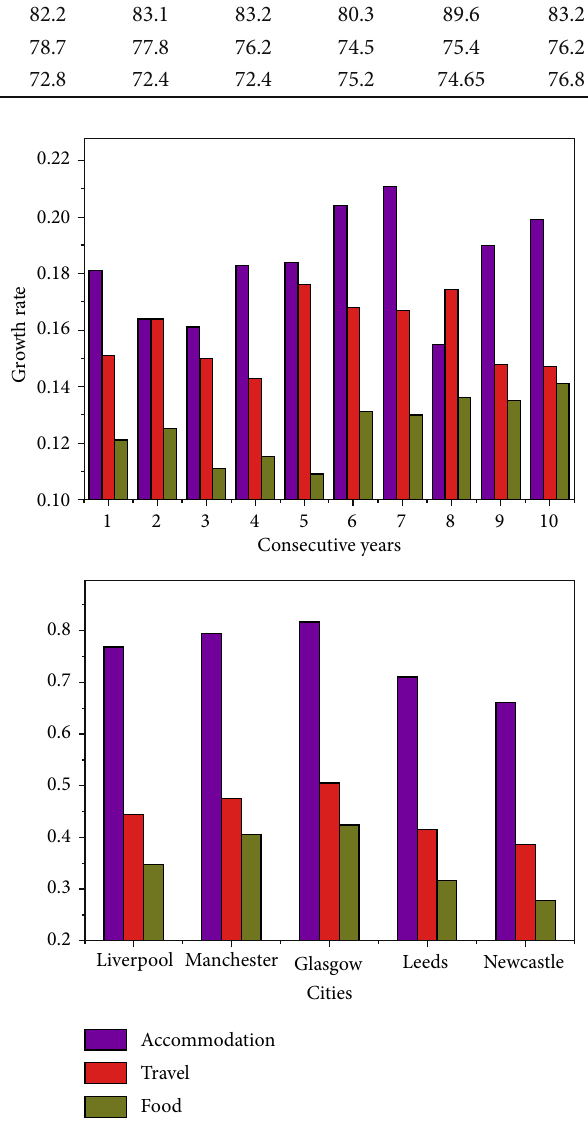
Figure 8: Growth rate (consecutive